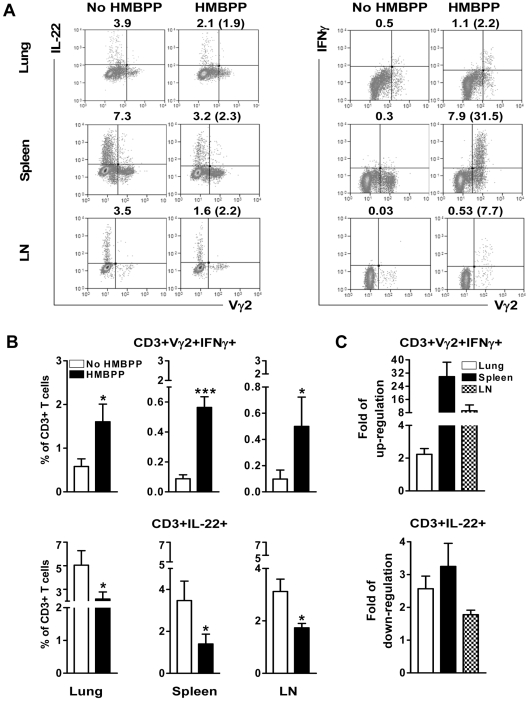
Up-regulation of IFNγ-producing Vγ2Vδ2 T effector cells after HMBPP stimulation coincided with the down-regulated capacity of T cells to produce IL-22 de novo.(A) Representative paired flow-cytometry histograms from monkey RH7406 (lung), RH7720 (spleen), RH7357 (mesenteric lymph node) show intracellular cytokine staining data indicating that HMBPP stimulation up-regulated numbers of CD3+ IFNγ+Vγ2+ T cells (right) and down-regulated numbers of CD3+IL-22+ T cells (left) in lymphocytes from lungs, spleens and mesenteric lymph nodes (LN). Cells were gated on CD3. Percentage numbers of IL-22+ or IFNγ+Vγ2+ T cells in CD3 T cells are listed above individual histograms, and folds of up-regulation (the ratio of HMBPP-stimulated versus unstimulated) or down-regulation are indicated in parentheses. Note that 1 hour HMBPP stimulation did not increase the number of entire Vγ2Vδ2+ T cells (including both IFNγ+ and IFNγ- Vγ2Vδ2+ T-cell populations) in CD3+; the percentage of Vγ2Vδ2+ T cells in CD3+ remained similar in the presence or absence of HMBPP (HMBPP enabled some IFNγ- Vγ2Vδ2+ T cells to become IFNγ+ Vγ2Vδ2+ T cells). The decreased numbers of IL-22-producing T cells were not due to expansion of Vγ2Vδ2+ T cells after 1-hr HMBPP activation. (B) Comparative analyses of flow-cytometry data indicating that HMBPP stimulation up-regulated percentage numbers of IFNγ+Vγ2+ T cells (top panels) and down-regulated percentage numbers of IL-22+ CD3+ T cells (bottom) in lymphocytes from lungs (n = 6), spleens (n = 8) and mesenteric lymph nodes (n = 5). Data were means ± SEM derived from eight infected rhesus macaques and were gated on CD3. *, P<0.05, ***, P<0.001. (C) Comparative data indicating mean folds of up-regulation of CD3+IFNγ+Vγ2+ T cells (top) and down-regulation of CD3+IL-22+ T cells in lymphocytes from lungs (n = 6), spleens (n = 8) and mesenteric lymph nodes (n = 5). Data were derived from eight infected rhesus macaques and were gated on CD3.